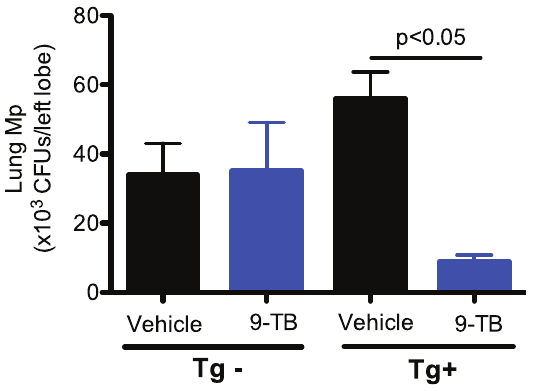
Figure 5. 9-TB reduces lung Mp load in CC10- CA IKK b transgene positive (Tg + ) mice. Left lungs from Mp-infected mice (24 hours after infection) were homogenized and plated on PPLO-plates to count Mp CFUs. 9-TB significantly reduced lung Mp load in Tg + mice, but had a minimal impact on Mp load in transgene negative (Tg–) mice. N=4– 6 mice per group. Data are expressed as means 6 SEM.